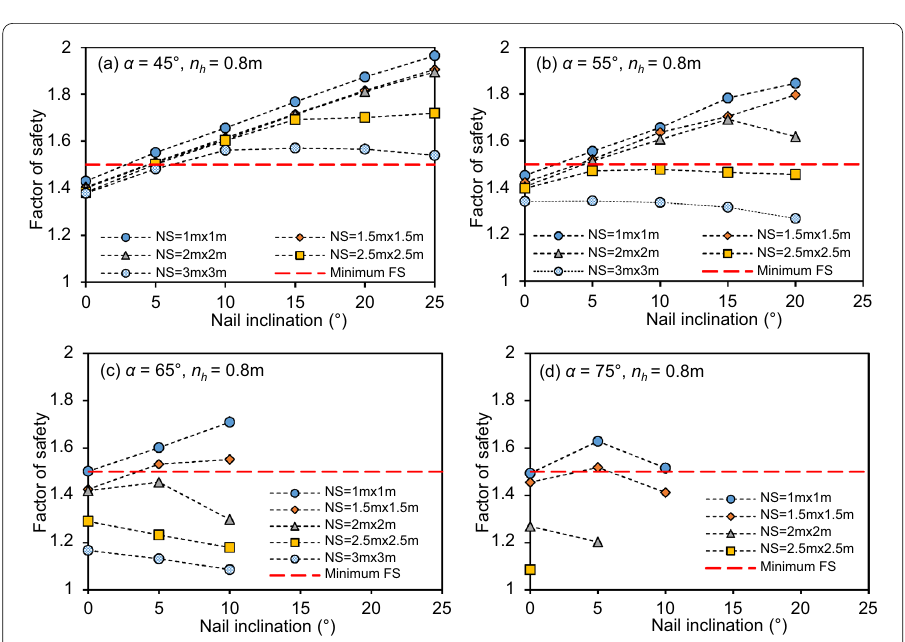
Fig. 8 The effect of nail head size equal to 0.8 m in four different slope